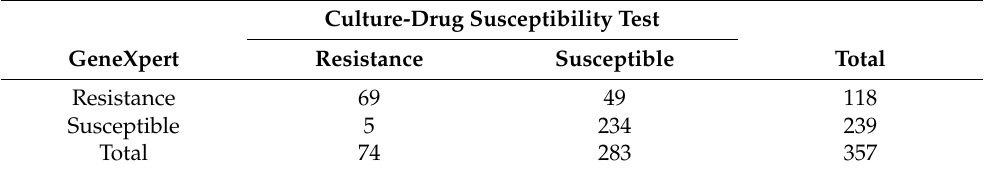
Table 1. Comparison of rifampicin resistance results of conventional culture method versus GeneXpert.